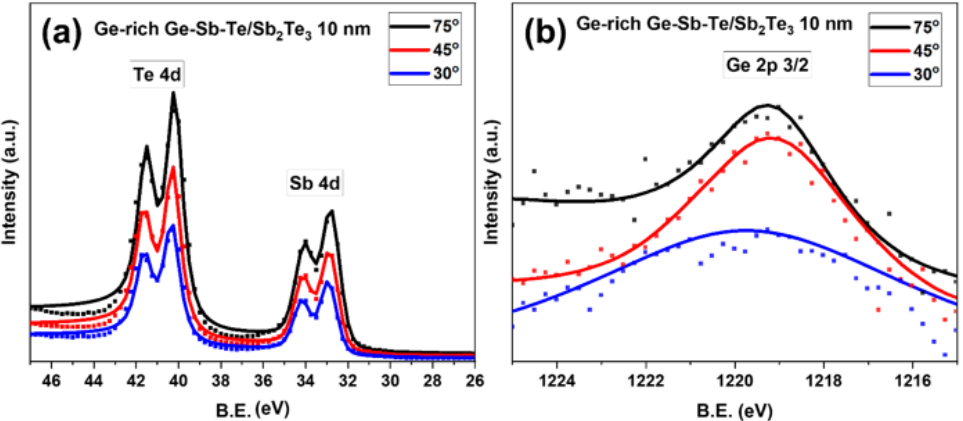
Figure 5. XPS spectra for ( a ) Te_4d, Sb_4d; and ( b ) Ge_2p regions collected at 30° (blue), 45° (red) and 75° (black) take-off angles for GGST/ST core-shell NWs with 10 nm shell thickness; (dots– experimental data; solid lines—fit).